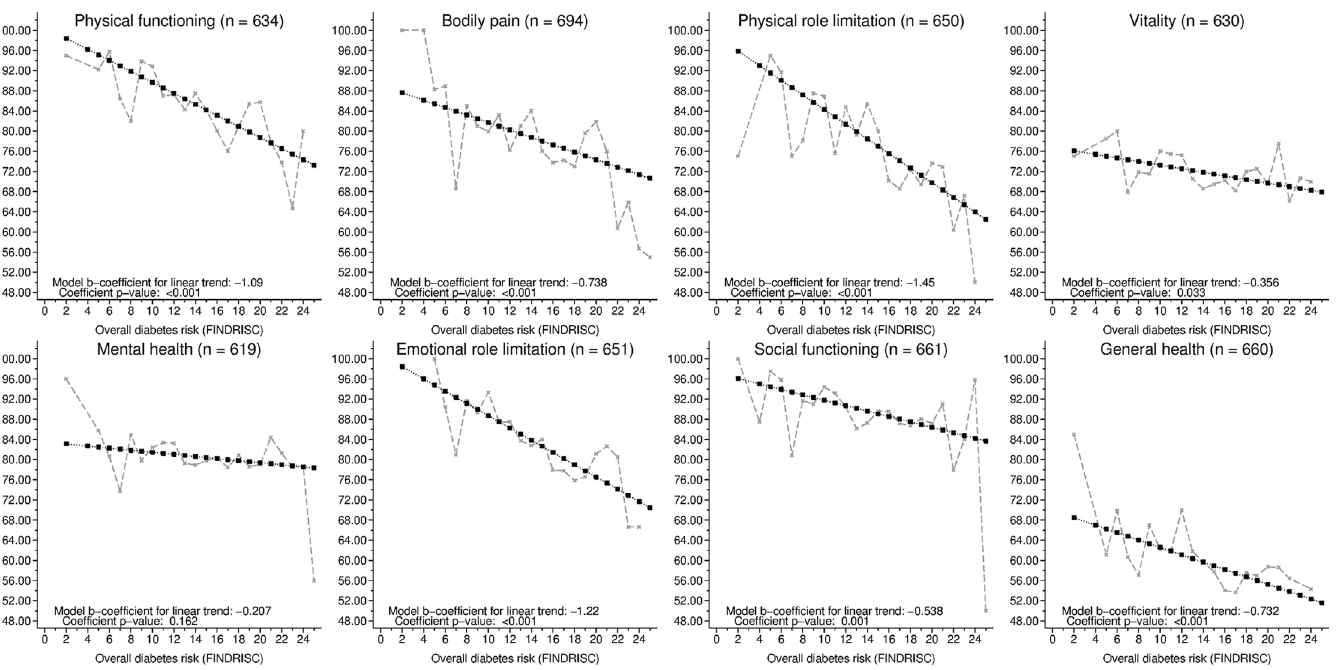
Fig 4. Mean observed HRQoL (SF-36) dimension values in relation to FINDRISC. Linear trends were fitted to data using ordinary least squares regression. The corresponding variance was estimated using a bootstrap procedure with 1,000 replications. HRQoL: Health-related quality of life. FINDRISC: Finnish Diabetes Risk